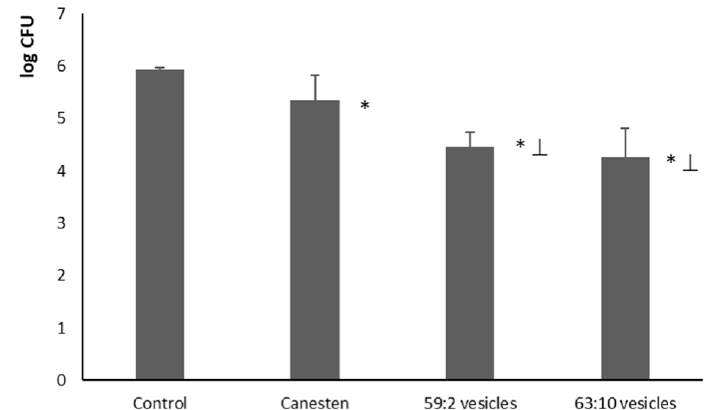
Figure 7. Total count of C. albicans (CFU) in the skin samples of mice 24 h after the application of Canesten ® cream and clotrimazole-loaded 59:2 and 63:10 hybrid vesicles. Values are expressed as mean ± standard deviation ( n = 4). The symbol * indicates values that were statistically different from control group and the symbol ⊥ indicates values that were statistically different from Canesten ® (reference group).